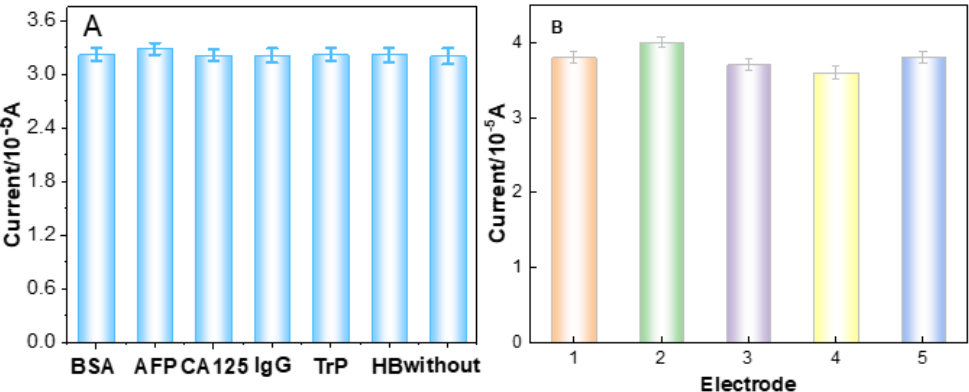
Figure 7. ( A ) Study of the specificity of the immunosensor towards various interferences: the currents towards 1.0 ng mL − 1 CEA without and with 20.0 ng mL − 1 BSA, AFP, CA125, IgG, Trp and Hb (error bar = SD, n = 3). ( B ) The reproducibility of the immunosensor.